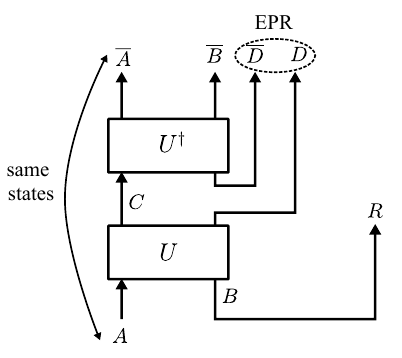
Figure 13 . Reconstruction of the interior operator D . If DD were to be measured in EPR pair, A and A must be identical quantum